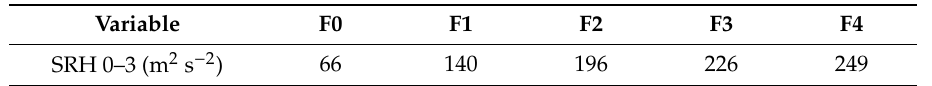
Table 4. Reference values for SRH 0–3 from [62] for each tornado category according to the Fujita